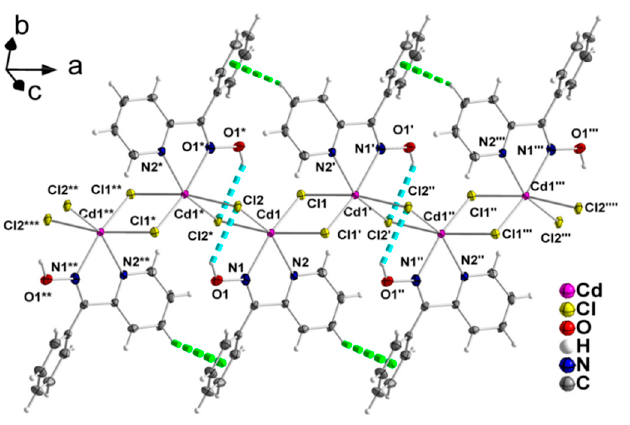
Figure 5. A small portion of one zigzag chain formed parallel to the ‘a’ axis in the crystal structure of 2 . The thermal ellipsoids are presented at the 50% level. The dashed cyan and light green lines represent O1-H(O1) ∙∙∙ Cl2 hydrogen bonds and C-H- π interactions [C3-Cg1 3.502(5) Å, C3-H(C3) 0.950(4) Å, H(C3) ∙∙∙ Cg1 2.952(1) Å, C3-H(C3) ∙∙∙ Cg1 118.4(3)°], respectively; C3 is a 2-pyridyl carbon atom and Cg1 is the centroid of the phenyl ring of phpaoH. Symmetry codes: (‘) –x + 2, − y + 2, − z + 1; (‘’) x + 1, y, z; (‘’’) –x + 3, − y + 2, − z + 1; (‘’’’) x + 2, y, z; (*) –x + 1, − y + 2, − z + 1; (**) –x, y, z; (***) –x, − y + 2, − z + 1. Table 5. Hydrogen bonding interactions (Å, deg) in the crystal structure of {[CdCl 2 (phpaoH)]} n ( 2 ).